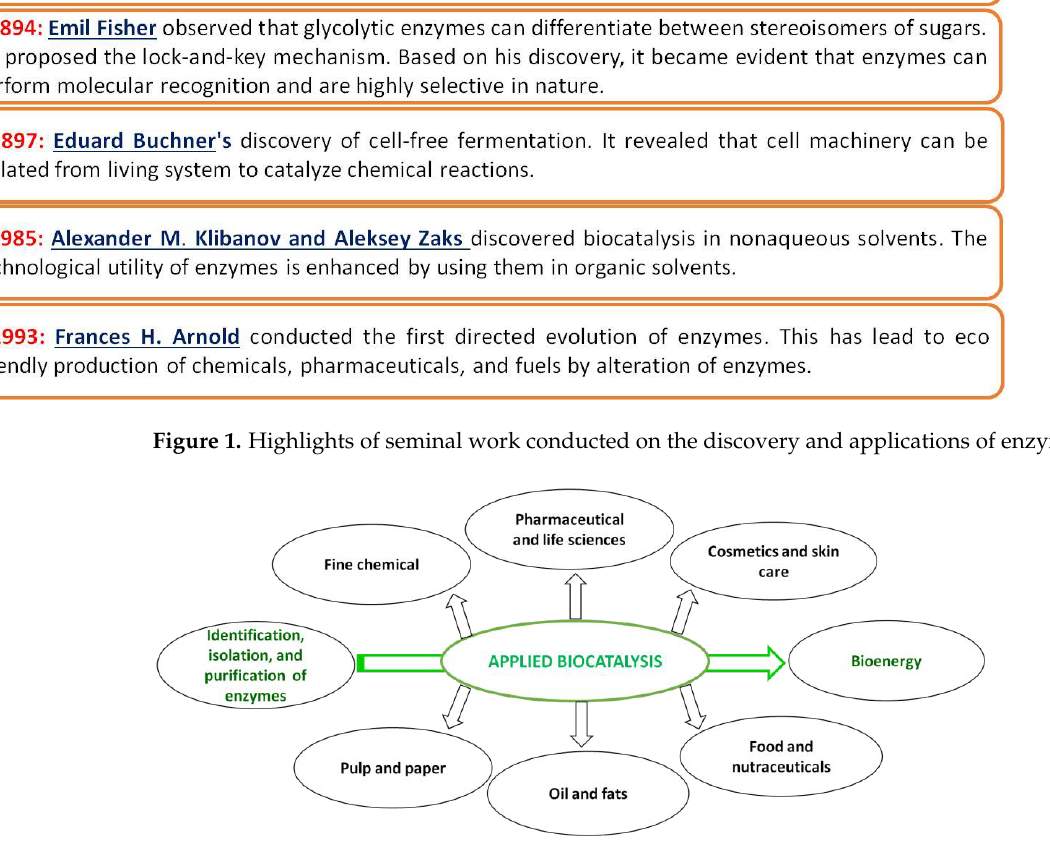
Figure 2. Industrial applications of biocatalysis as reported in the literature.